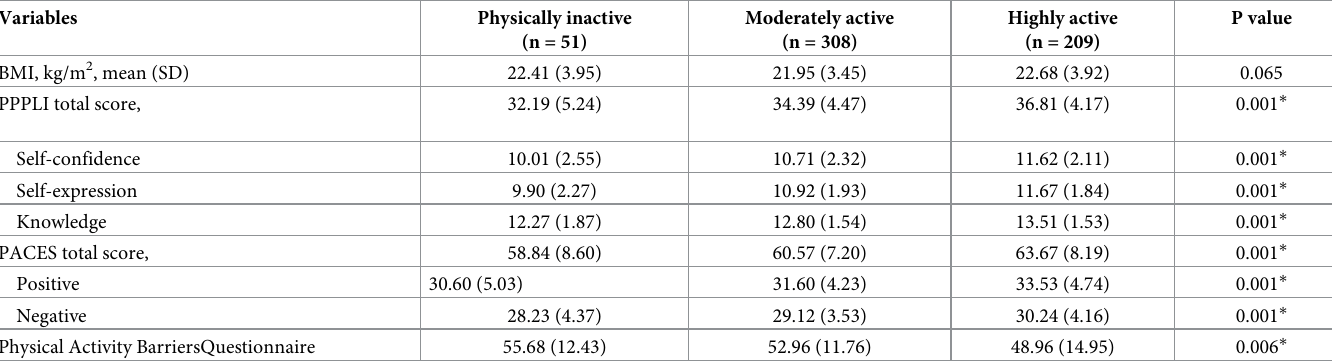
Table 2. Comparison of the BMI, physical literacy, enjoyment from physical activity, and, barriers to physical activity based on physical activity